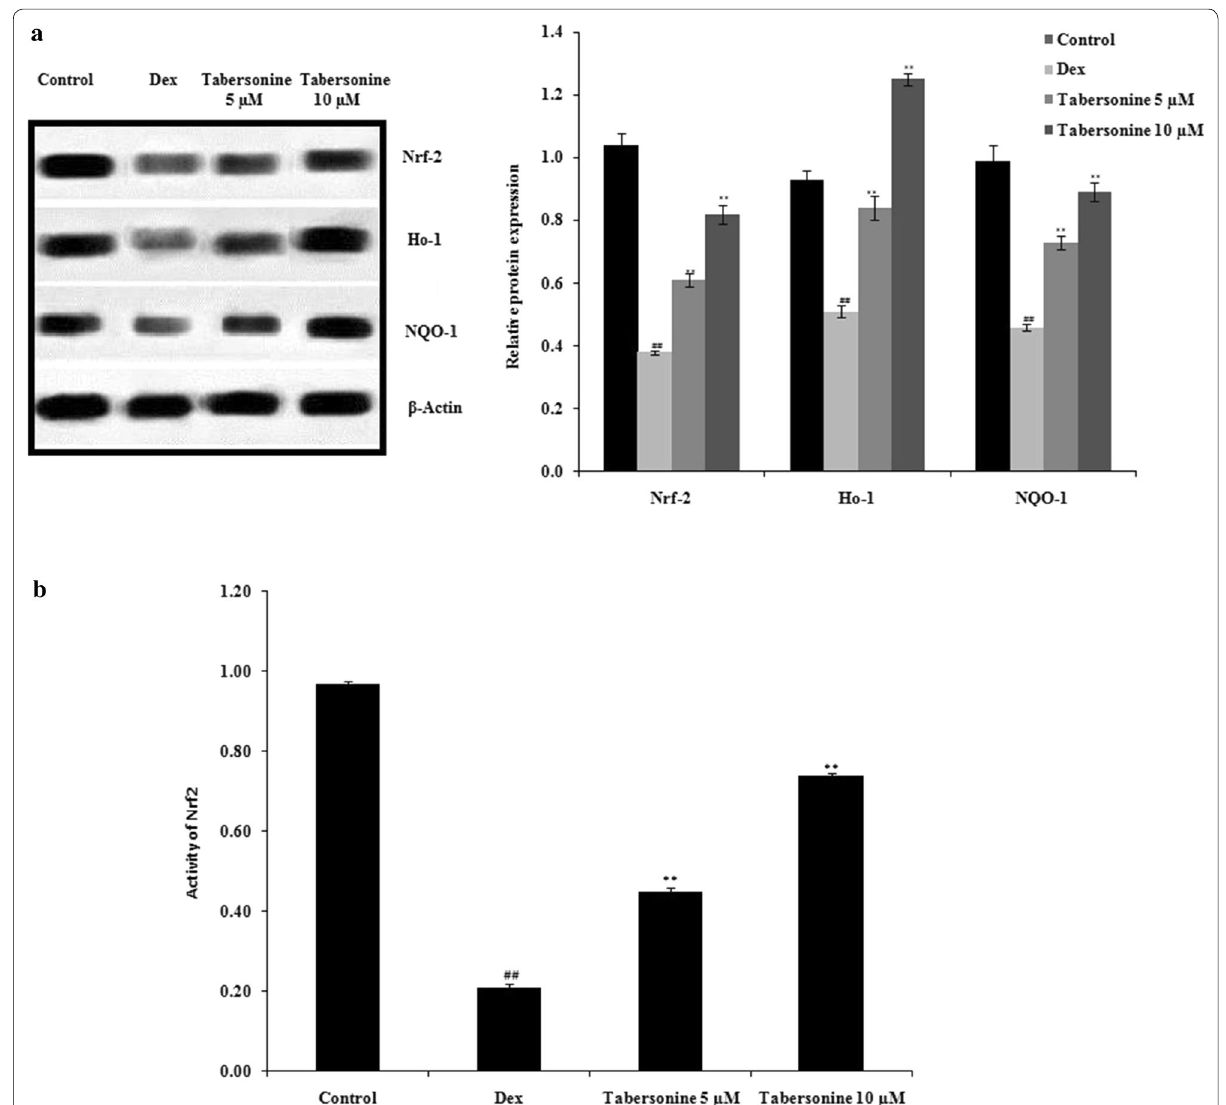
Fig. 7 Effect of tabersonine on Nrf2 pathway activity in dexamethasone-treated osteoblasts. a Nrf2, Ho-1 and NQO-1 protein levels in osteoblasts, as revealed by western blotting. b Nrf2 activity, as determined using the TransAM Nrf2 Kit.